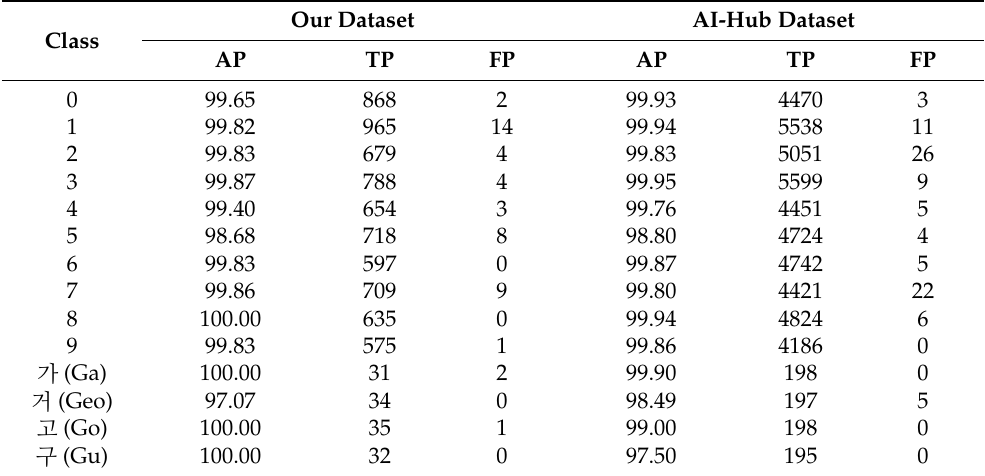
Table 11. Performance of the LPC detector per class; classes highlighted in gray are excluded for adjusted